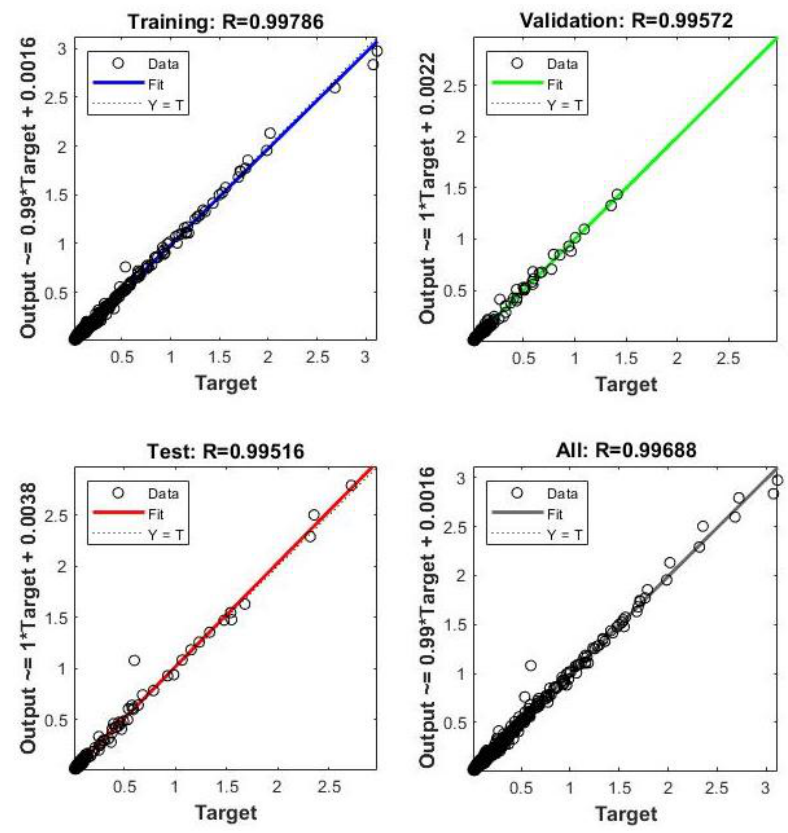
Figure 12. Regression graphs of the established ANN model.